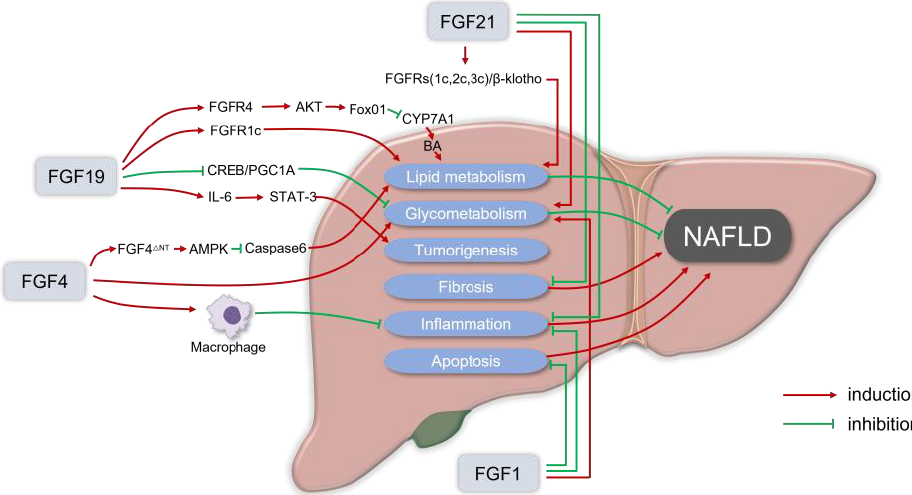
Figure 1. The rationale for fibroblast growth factors (FGFs) in the treatment of nonalcoholic fatty liver disease (NAFLD). FGF19 usually binds to the FGFR1c or FGFR4/ β -Klotho complex to enhance lipid metabolism that can alleviate NAFLD. FGF19 inhibits the orphan nuclear receptor small het- erodimeric partner (SHP)-dependent cholesterol 7 α hydroxylase (CYP7A1) to prevent BA-induced liver injury in NASH. For glycometabolism, FGF19 inhibits gluconeogenesis by suppressing the cAMP response element-binding protein (CREB)/peroxisome proliferator-activated receptor γ coactivator 1- α (PGC1 α ) signaling cascade. Meanwhile, in FGF19 transgenic mice, it was observed that FGF19 could transform normal hepatocytes into malignant cells via IL-6 by activating the STAT-3 pathway. FGF21 usually recruits β -Klotho and FGFRs (FGFR1c, FGFR2c, or FGFR3c) as coreceptors for activa- tion, to reduce lipid deposition in hepatocytes in a non-insulin way, and the FGF21 receptor agonists can inhibit liver inflammation, fat content, and liver fibrosis in the in vitro and in vivo models of liver fibrosis and NASH. Physiological doses of FGF21 can reduce the body weight, and fat content can also alleviate insulin resistance, hyperglycemia, and dyslipidemia. In the NASH mice model, the administration of recombinant FGF1 (rFGF1) ameliorated liver inflammation and hepatocyte injury, and FGF1 normalized the blood glucose levels of both gene- and diet-induced obese mice. FGF4 is also essential in regulating glucose and lipid metabolism, as well as maintaining systemic metabolic homeostasis, which can ameliorate insulin resistance and inhibit the infiltration and the development of inflammation. FGF4 acts directly on macrophages to block inflammatory responses in the liver and adipose tissue. rFGF4 ∆ NT , a non-mitotic rFGF4 analog, can have a significant protective effect on NASH through an AMPK-dependent signaling pathway.